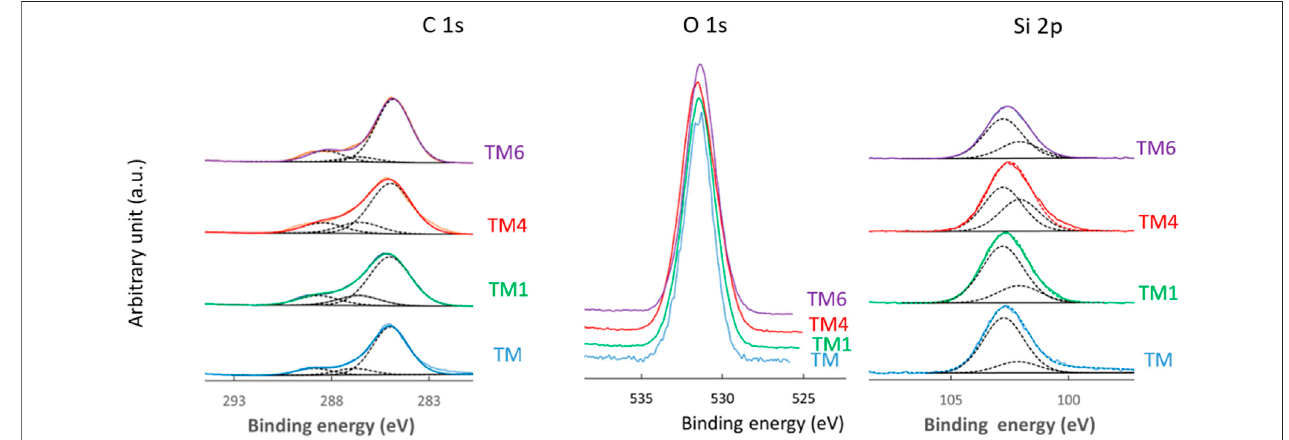
FIGURE7| High-resolutionXPSC1s,O1sandSi2pspectraofaluminiumcoatedwithTMcoatingsbeforeimmersionandafterselectedimmersiontimesin0.1 M NaCl (TM1 after 1 day, TM4 after 4 days and TM6 after 6 days). The C 1s and Si 2p spectra were deconvoluted using component peaks as described in the text: C − C/ C − H, C − O and C (cid:1) O, and R 3 − Si − O 1 (101.4 eV) and R 2 − Si − O 2 (102.1 eV) chemical environment, respectively.